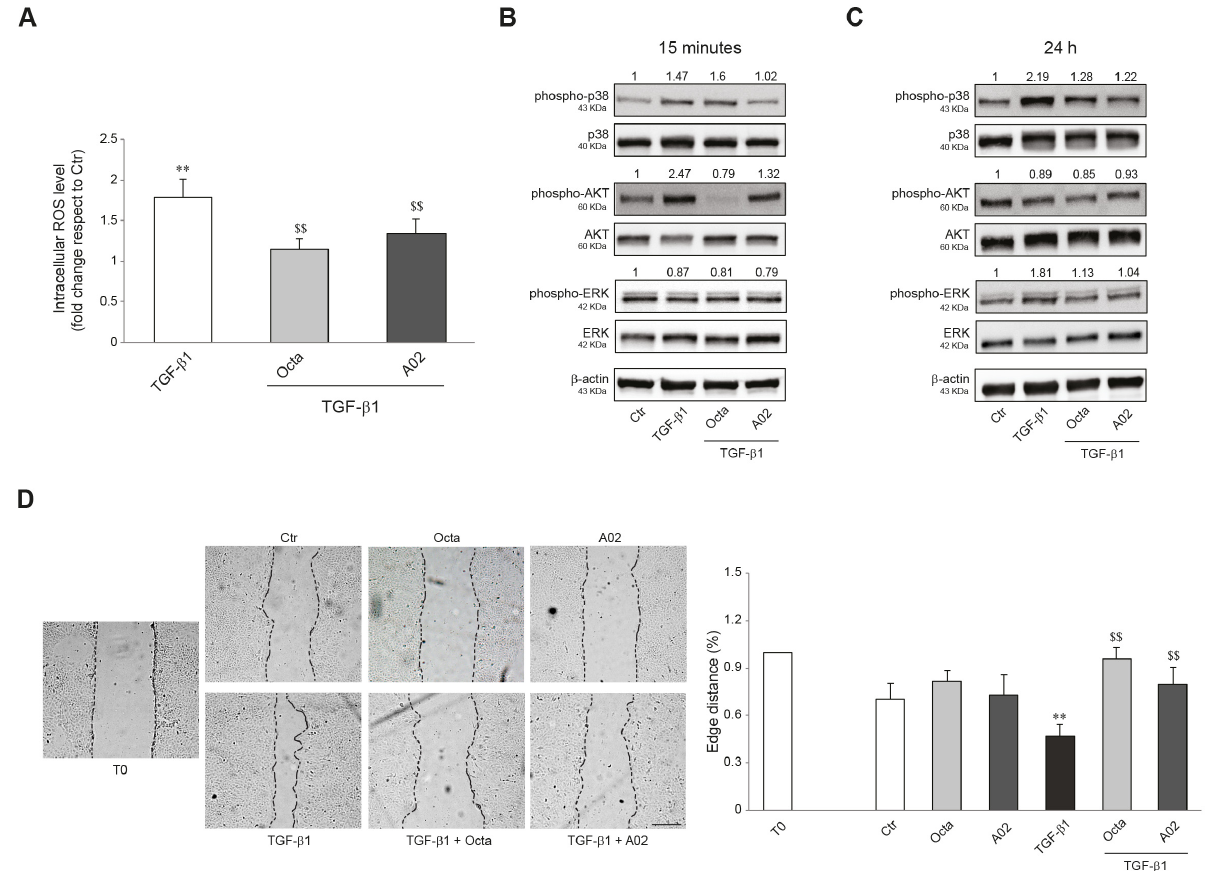
Figure 4. Effects of A02 and Octa on ROS generation, inflammation, and migration in A431 cells. ( A ) ROS levels in A431 pre-treated with Octa and A02 (90 µM) for 1 h and then exposed to TGF- β 1 (15 ng/mL) for 24 h. Results are expressed as the fold change with respect to untreated control cells (** p < 0.01 vs. untreated control; $$ p < 0.01 vs. TGF- β 1-treated cells). Western blot analysis of phospho- p38, p38, phospho-AKT, AKT, phospho-ERK, and ERK protein expression in A431 pre-incubated with Octa or A02 (90 µM) for 1 h and then treated with TGF- β 1 (15 ng/mL) for 15 min ( B ) and 24 h ( C ). β -actin was used as an endogenous loading control for Western blot analyses. Densitometric scanning of band intensities was performed to quantify the change in protein expression. Data rep- resent the mean ± SD of three independent experiments and are expressed as fold change with re- spect to untreated control cells (control value taken as 1-fold in each case). ( D ) Representative im- ages of the scratch assay of A431 cells treated with Octa or A02 alone or after TGF- β 1 stimulation at T0 and 24 h. Bar: 200 µm. Quantitative analysis resulting from the measurements of the covered scratched area. The results are expressed as fold change with respect to T0 which was set as 1 by de fi nition (** p < 0.01 vs. T0; $$ p < 0.01 vs. TGF- β 1).